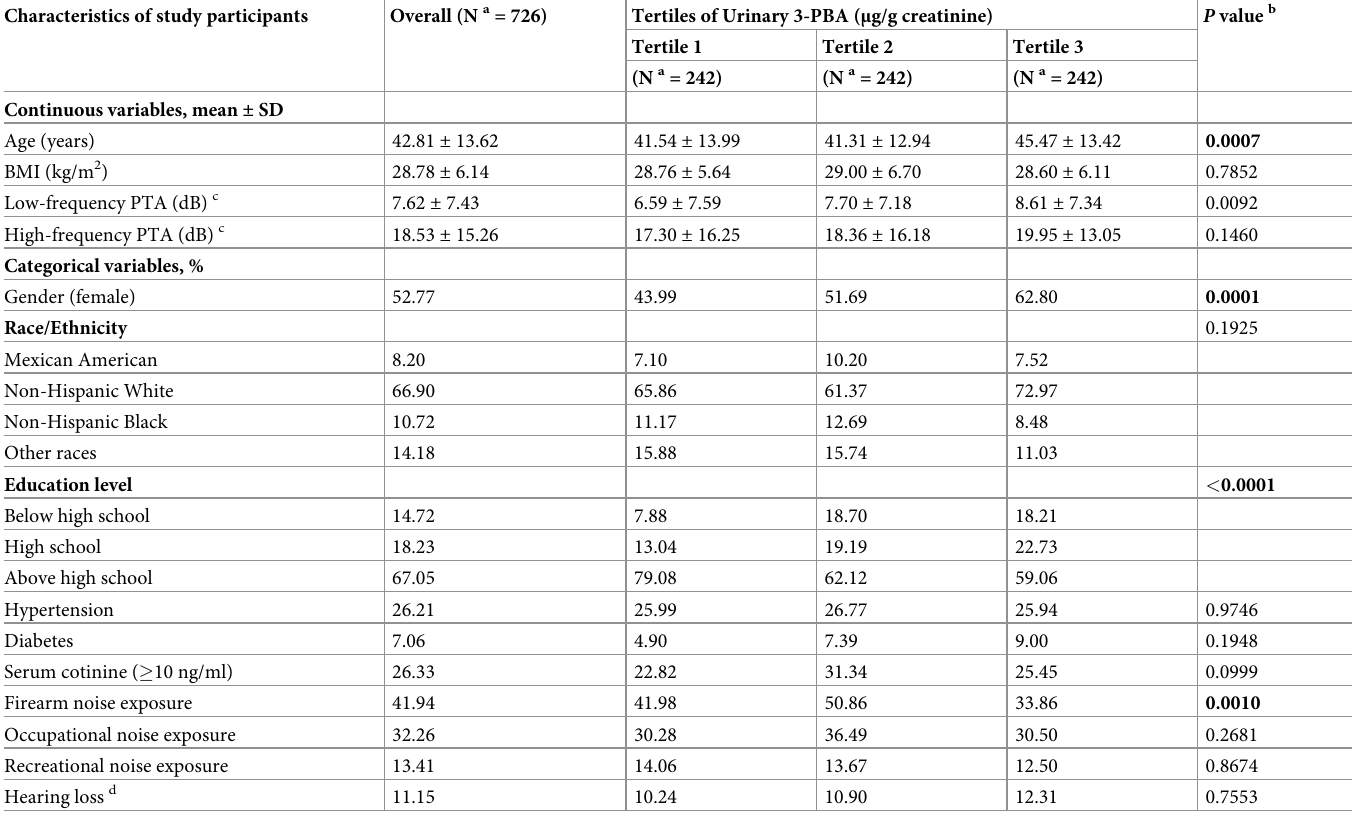
Table 2. The weighted demographic characteristics of study